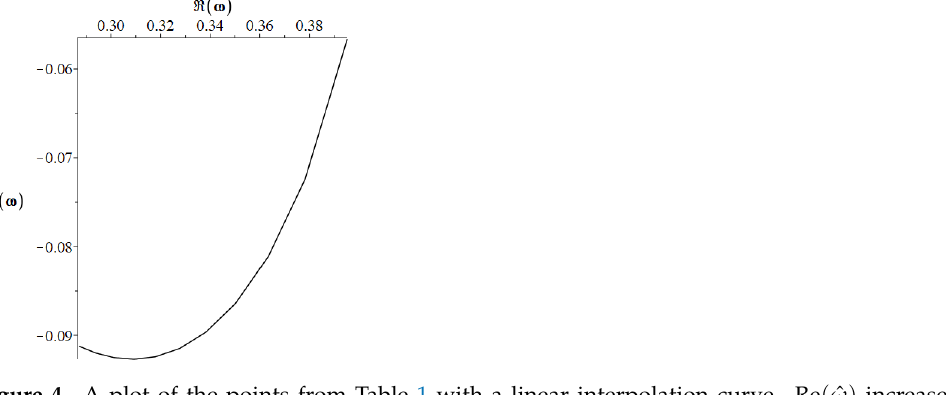
Figure 4. A plot of the points from Table 1 with a linear interpolation curve. Re ( ˆ ω ) increases monotonically with ˆ a , hence increasing ˆ a corresponds to one moving from left to right.